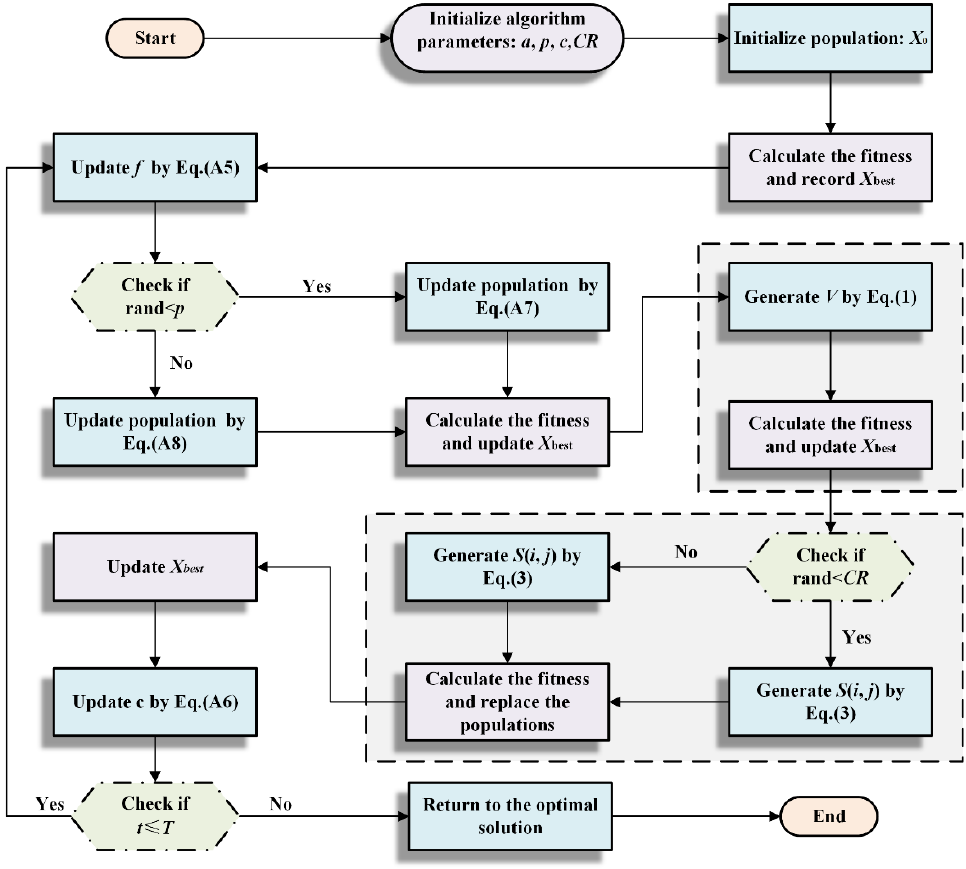
Figure 1. Flowchart of CBBOA.